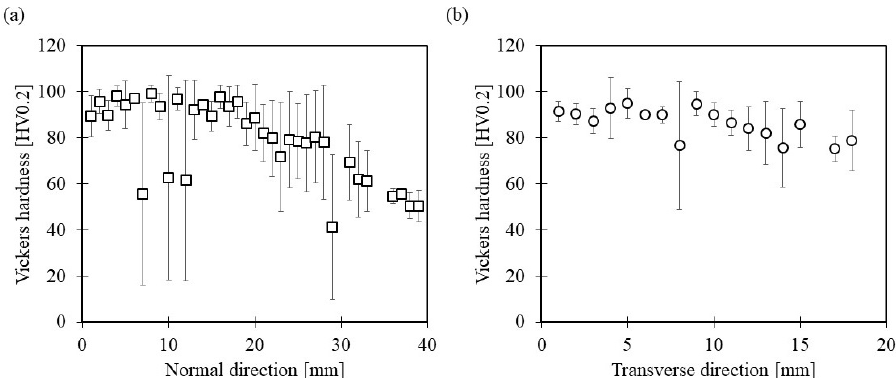
Figure 11. Microhardness distribution of WAAM AA2319 in ( a ) normal and ( b ) transverse direction.